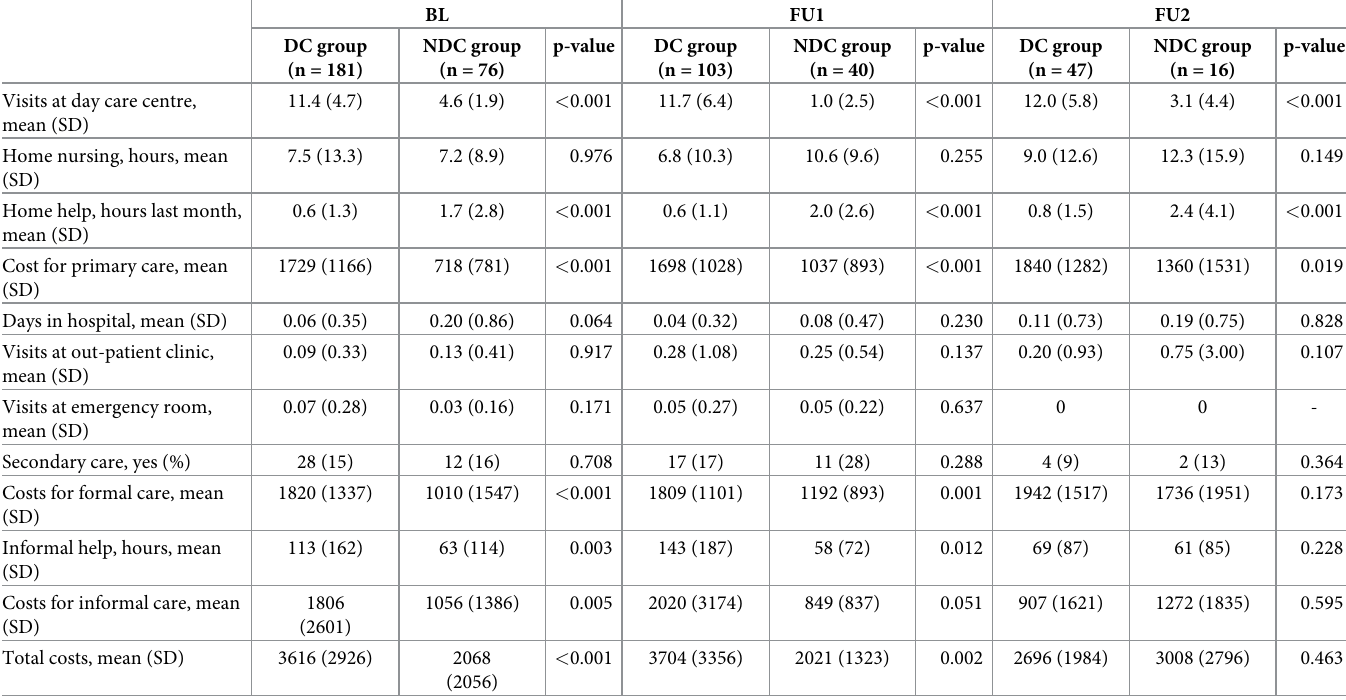
Table 2. The use of primary, secondary and informal care and costs in the month prior to BL, FU1 and FU2, respectively.